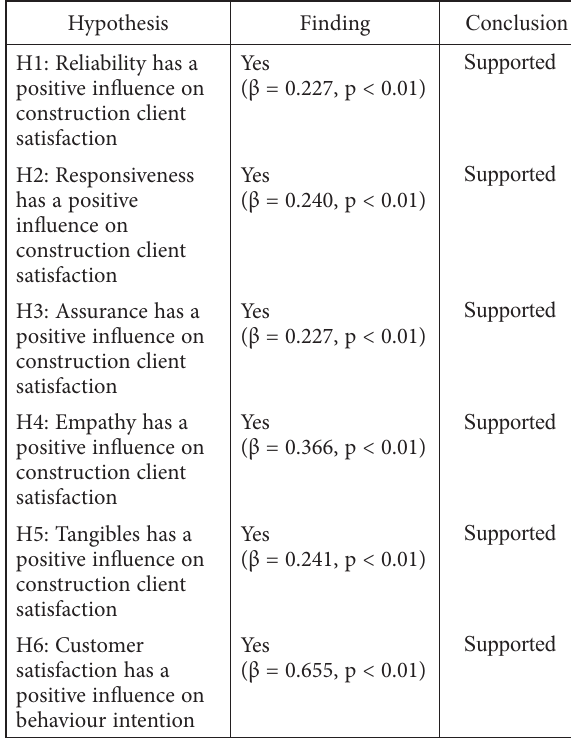
Table 4. Hypotheses conclusions of the